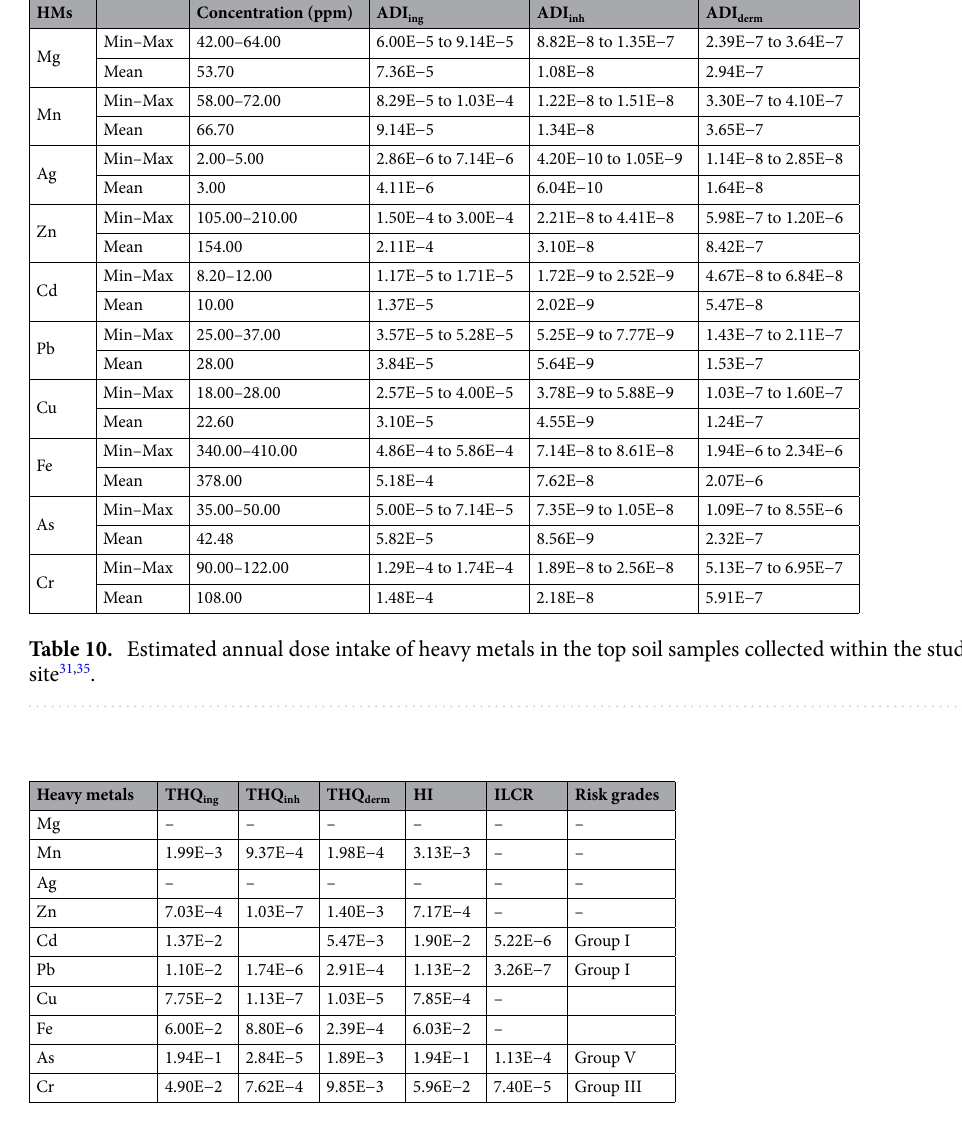
Table 11. Estimated mean HI and ILCR of the heavy metals in soil samples collected within the study site 31,35